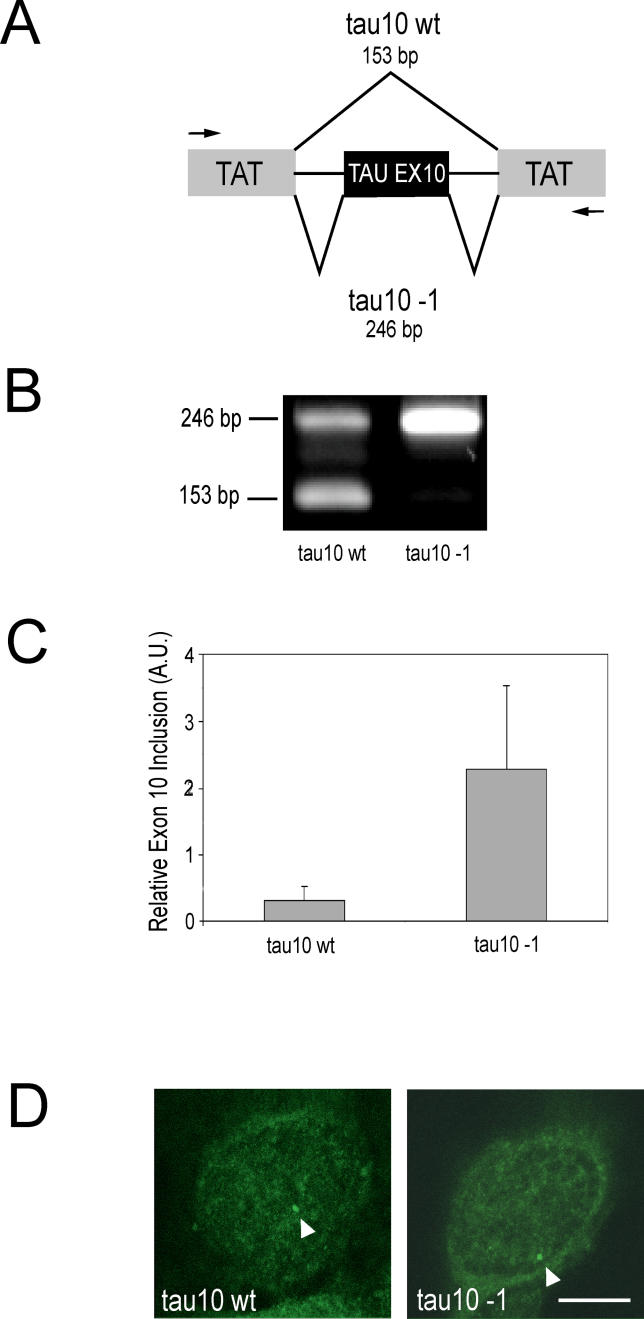
Characterization of Stable Cell Lines Expressing Alternatively Spliced tau Minigenes(A) Schematic representation of the tau exon 10 minigene system. Alternative inclusion or exclusion of exon 10 as observed for endogenous tau is recapitulated in a minigene containing flanking HIV-TAT exons.(B) Preferential inclusion of tau exon 10 detected by gel electrophoresis. The wttau exon 10 (tau10wt) is evenly included or excluded from the mRNA, whereas a tau exon 10 containing a T>C mutation at position −1 of exon 10 (tau10−1) is predominantly included in the same context. Exon 10 inclusion is detected as a 246-bp by RT-PCR using primers (arrows) in the TAT exons. Exon 10 exclusion is detected by a 153-bp band.(C) Quantitative real-time PCR analysis to determine exon 10 inclusion. Results are averages ± standard deviations from at least three experiments.(D) RNA-FISH using nick-translated probes against the tau minigene to detect sites of tau transcription. The vast majority of cells in a stable cell population contained one or two tau minigene insertion sites. Arrowheads indicate tau transcription sites. Scale bar = 3.5 μm.